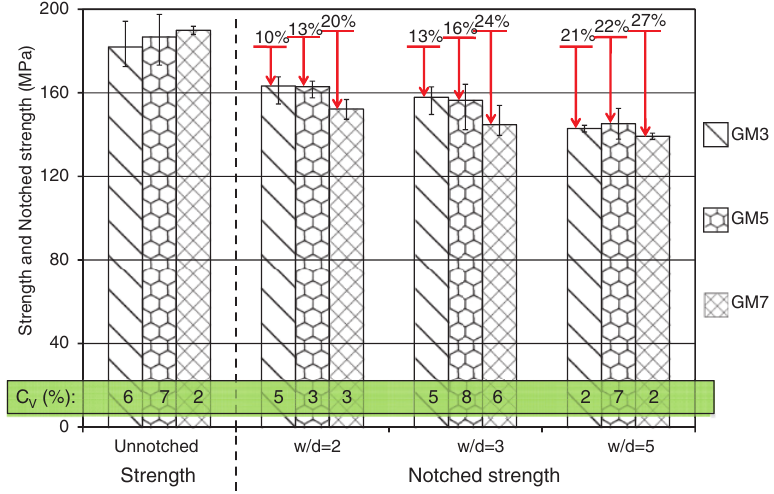
Figure 5 Notched strength decreasing of different specimens in